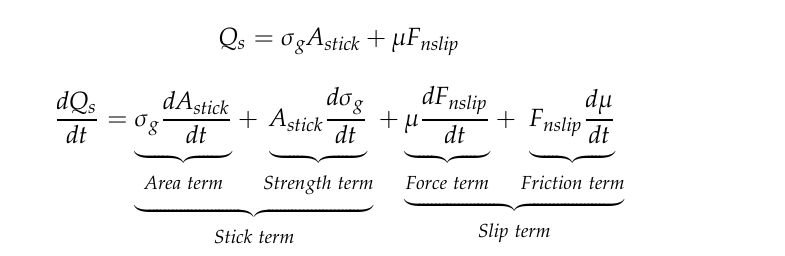
Figure 11. Change of stick area (dotted line) within stick phase of the 5 µm/s test, arrow shows the movement of counter surface; A – E correspond to Figure 10. The top graph of Figure 10 shows the alternating contact area with the corresponding stick-slip behavior. It can be observed that the contact area decreased during the stick phase and increased abruptly with the slip movement of the specimen. It is understood that the whole contact area deformed largely as a consequence of the shear stress. The outer region of the contact area, the slip region in particular, experiences a transition from the contact state to non-contact state. Prior to the first slip, a small drop of friction force can be identified in Figure 10. This phenomenon has also been identified by other groups [42]. The friction force increased in a nearly linear way until reaching a peak force. At the peak point, the friction force dropped abruptly from over 400 N to around 200 N. At the same time, the static friction transformed into dynamic friction in about 30 milliseconds. Taking a close look at the loading curve, before reaching the peak force, a small drop (about 1%) of